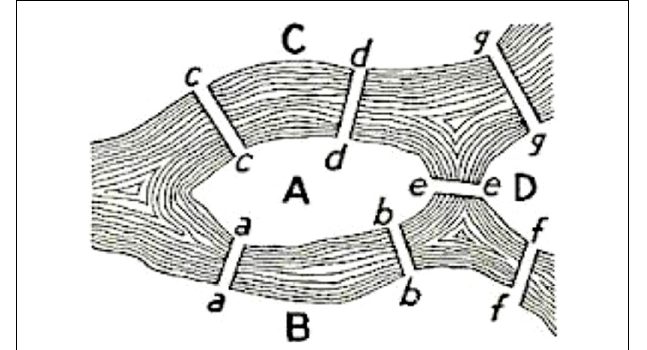
FIGURE 1 |The Konigsberg bridge problem: the seven bridges (edges) extremities are indicated by letters (nodes).